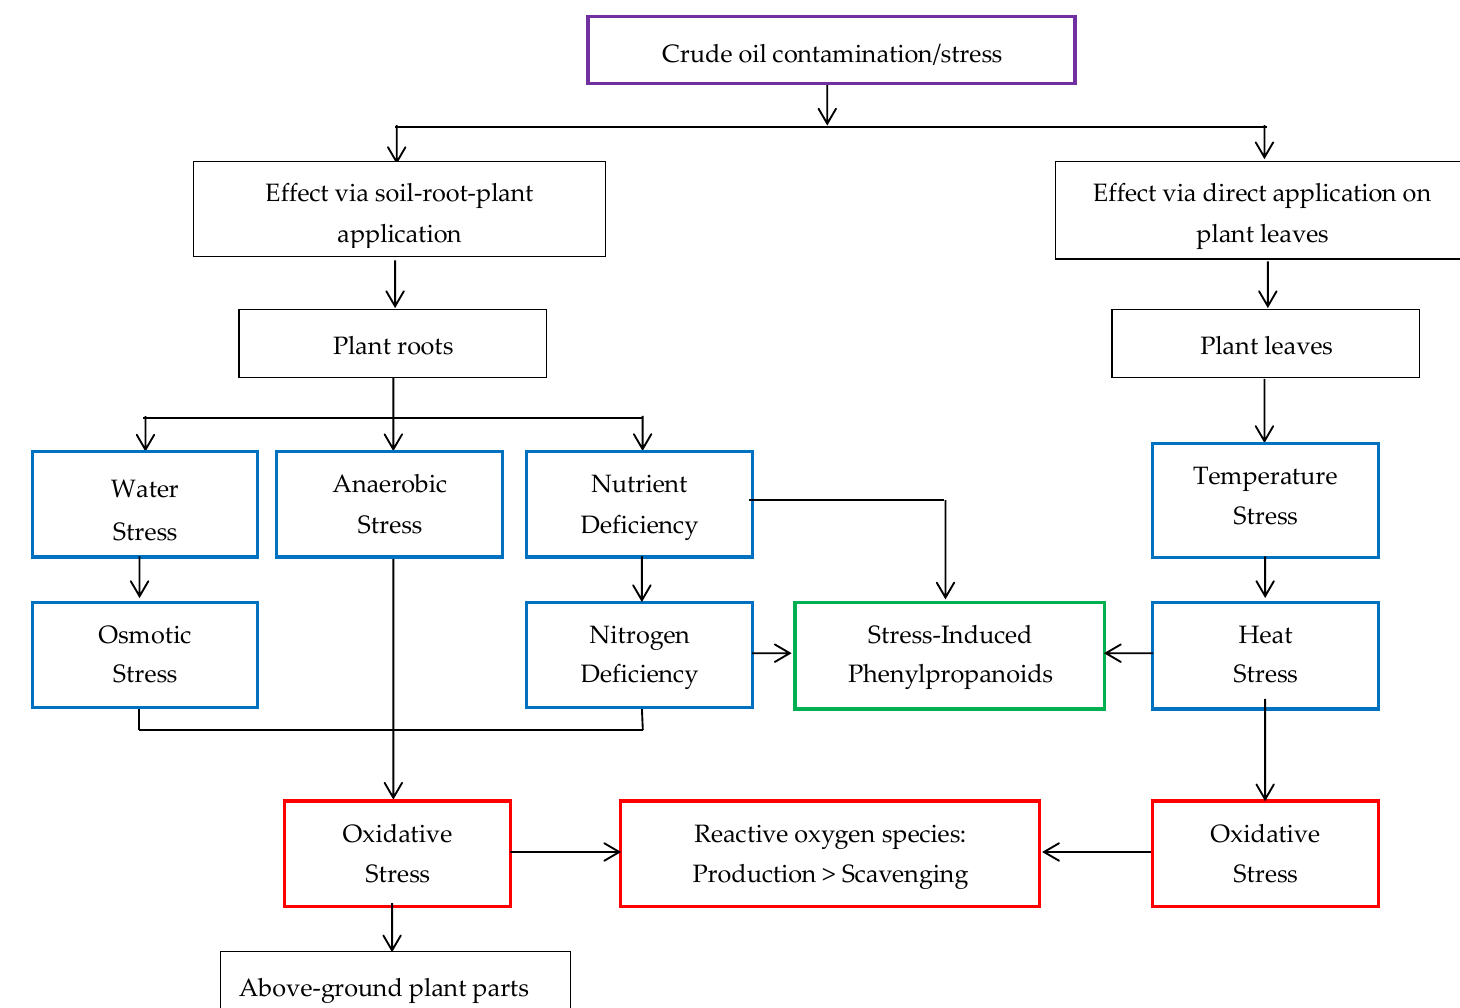
Figure 7. Illustration of the mechanistic link between crude oil contamination/stress and the crude oil-induced abiotic stresses as it affects agrifood production.